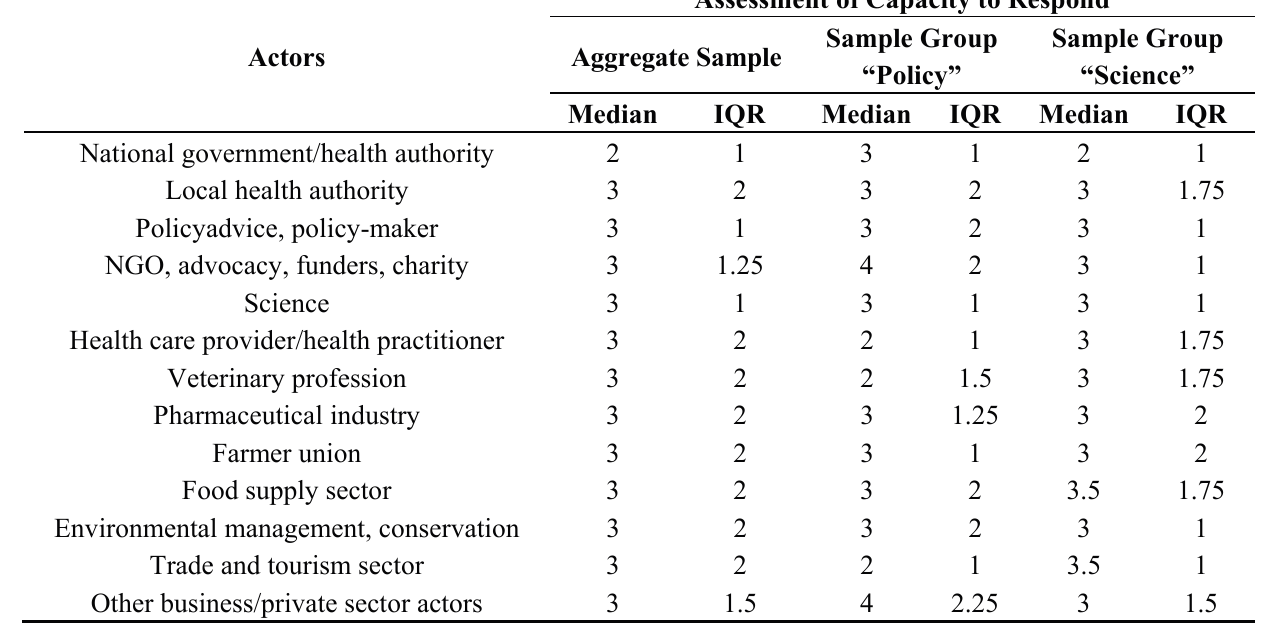
Table 5. Assessment of the capacity to respond of the actors, by the aggregate sample and the two sample groups “Policy” and